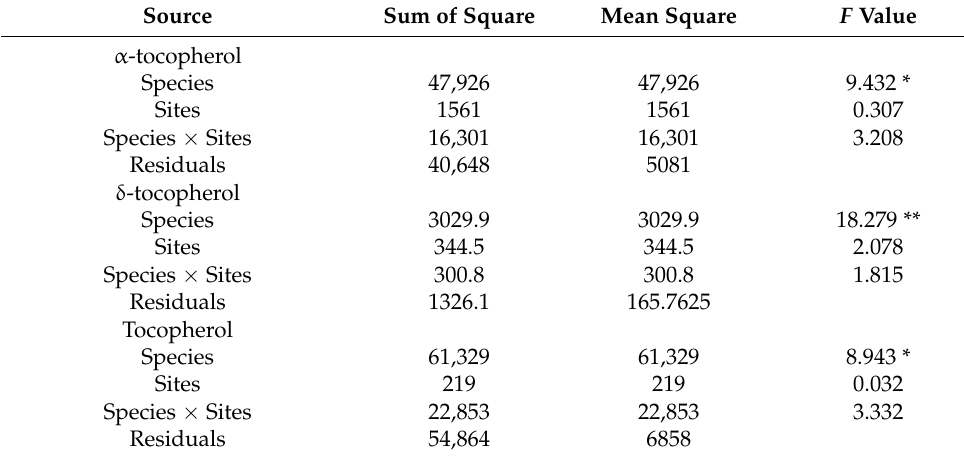
Table 3. Two-way analysis of variance (two-way ANOVA) of the micronutrients and secondary